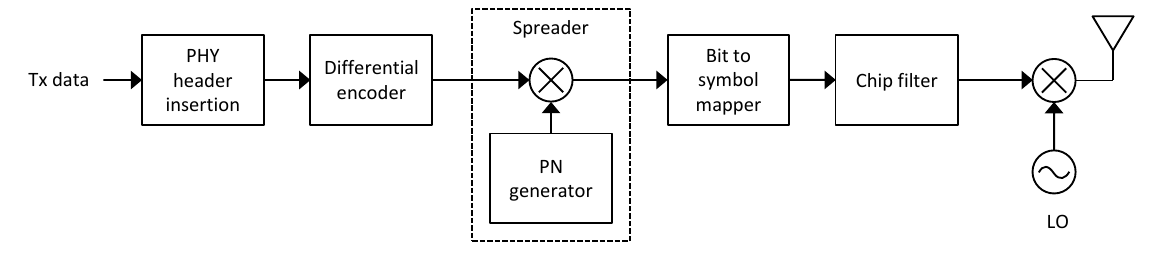
Simplified block diagram of the DSSS-based code division multiple access (DS-CDMA) transmitter implemented on the Marmote software-defined radio (SDR)